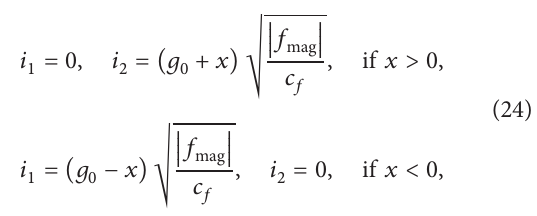
ruleForce model Figure 8: Switching